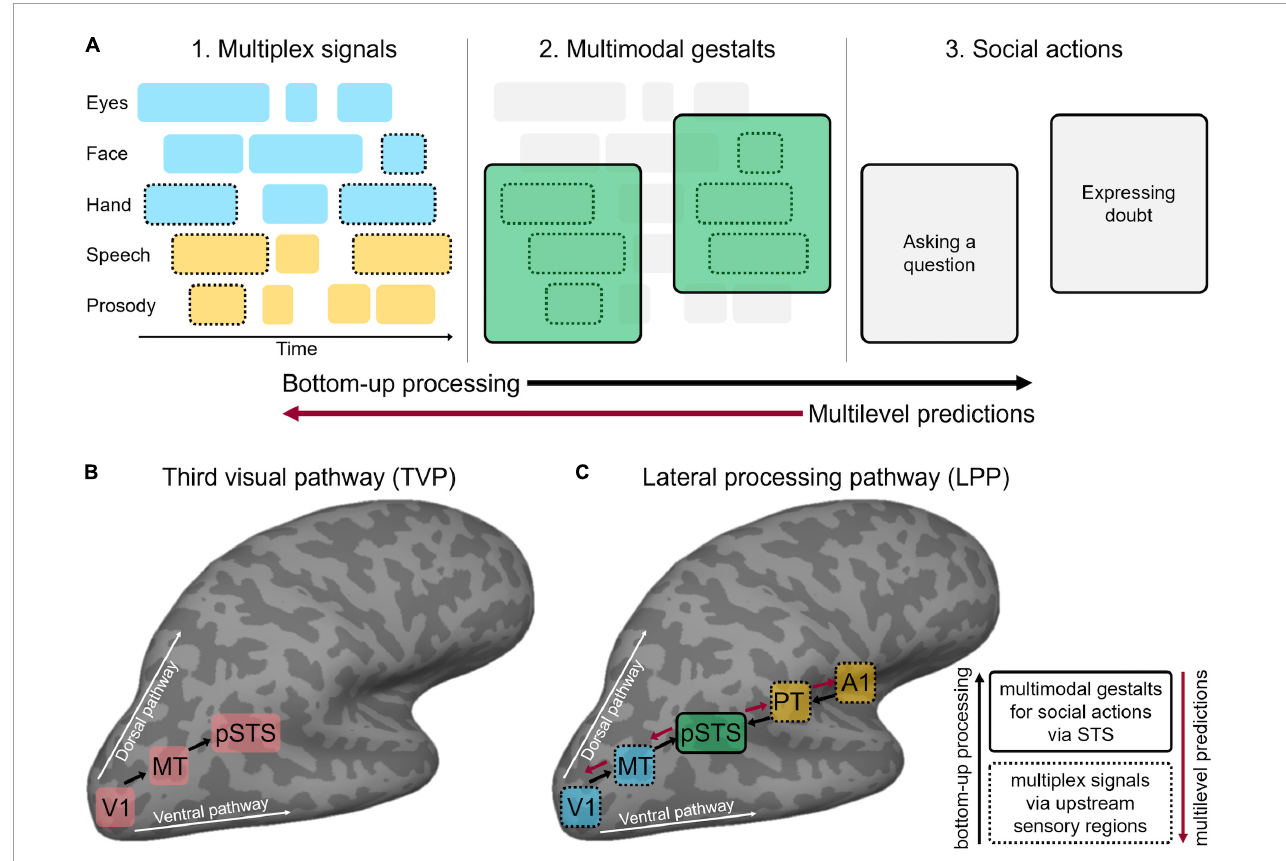
FIGURE1 (A) Face-to-face communication comprises multiple layers of discontinuous multimodal signals emitted by different articulators (eyes, face, etc.) over time (visual in cyan, auditory in yellow). To enable effective communication, interlocutors must bind only signals belonging to the same communicative action while segregating tangential, unrelated signals that do not share the communicative content. Temporal statistical regularities allow chunking coherent communicative inputs into multiplex signals (dashed contours) at a perceptual, pre-semantic level (A1). Further, statistical regularities between multiplex signals and communicative meanings generate multimodal gestalts (solid contours) that bear semantic and pragmatic value (A2) and thus signal a specific communicative intention in conversation, i.e., social action (A3). Finally, social action recognition may trigger top-down multilevel predictions across hierarchically organised linguistic and perceptual levels. Following a parallel processing framework, concurrent bottom-up sensory processing (black arrow) and multilevel predictions (red arrow) iteratively refine each other. (B) Schematic representation of the third visual cortical pathway (TVP) specialised for the dynamic aspects of social perception, as proposed by Pitcher and Ungerleider (2021). The pathway originates in the primary visual cortex (V1) and dissociates from both the ventral and dorsal pathways by projecting into the posterior portion of the superior temporal sulcus (pSTS) via motion-selective areas (MT). (C) Schematic representation of the multimodal lateral processing pathway (LPP) implementing the sensory processing gateway toward successful face-to-face communication, as proposed in the present perspective. The LPP originates in early visual (V1) and auditory (A1) areas and dissociates from ventral and dorsal pathways by projecting to the mid-posterior portion of STS via animacy and motion-selective areas (here, MT and PT only are represented for clarity of visualisation). Black arrows indicate bottom-up processing along the LPP hierarchy from upstream regions (dashed contours) responsible for multiplex signals (panel A1) to portions of the pSTS (solid contours) that contribute toward the implementation of multimodal gestalts (panel A2). Red arrows indicate top-down multilevel predictions via pSTS to upstream visual and auditory areas (in cyan and yellow, respectively). Panel (A) is based on Holler and Levinson,